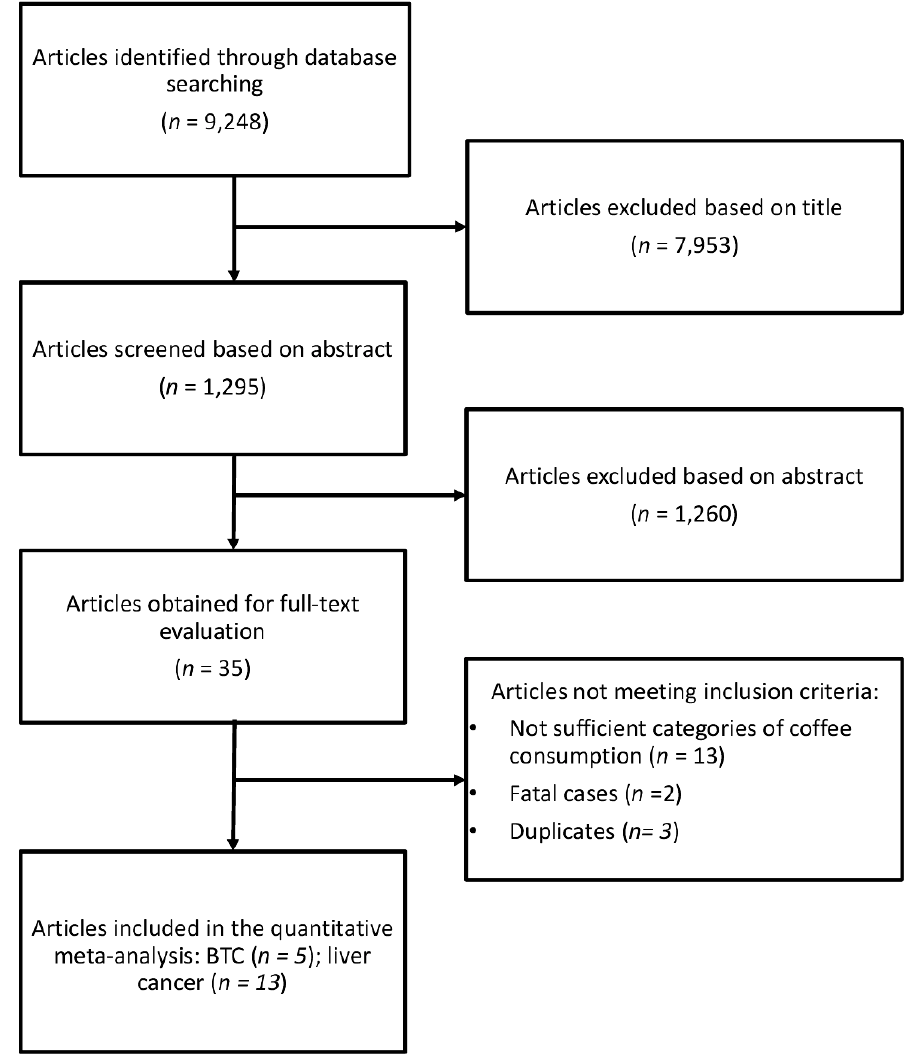
Figure 1. Flow chart and process selection of relevant studies exploring the association between coffee consumption and BTC and liver cancer risk.